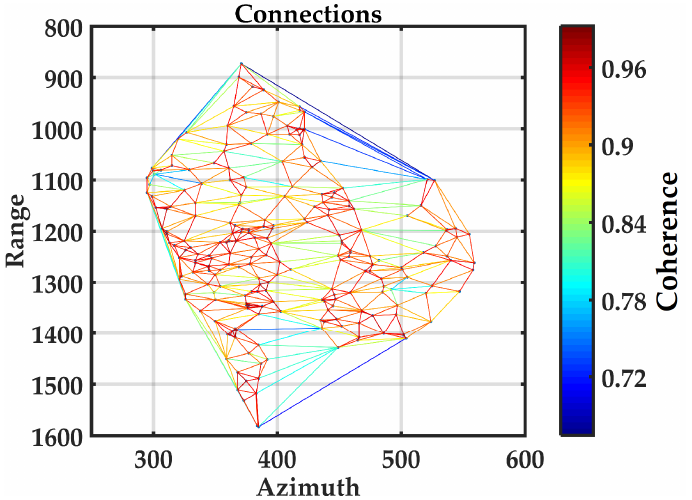
Figure 8. Triangulation network between the selected PSC points. The color lines represent the coherence of each connection between two close PSC points. Connections presenting coherence equal to or higher than 0.7 were used (example of descending VV data).